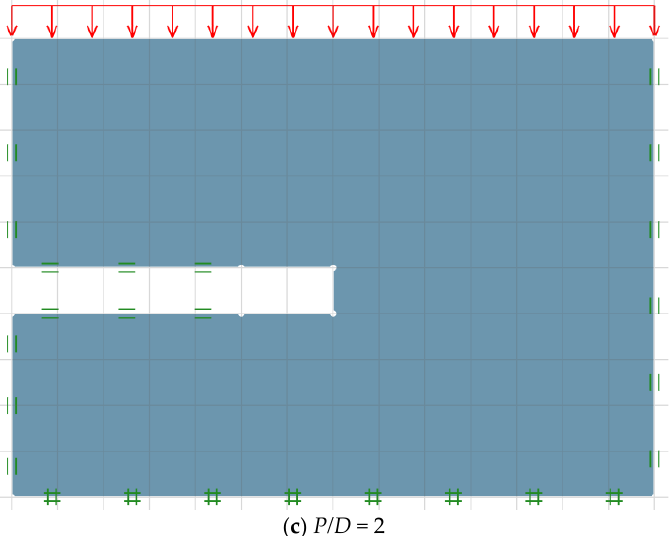
Figure 2. Typical model geometries for tunnel headings in rock masses ( C/D = 5, γ D/ σ ci = 0.01, GSI = 40, and m i = 30).